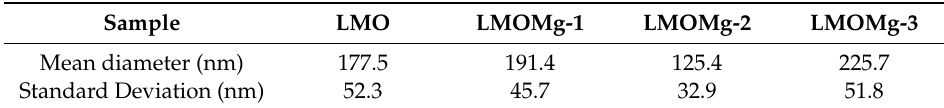
Figure 9. Differential and cumulative distribution of particle size of the nanometric powders of magnesium-doped manganese spinels: ( a ) LMO, ( b ) LMOMg-1, ( c ) LMOMg-2, and ( d ) LMOMg-3. Table 7. Results of statistical analysis of the particle size distribution for LiMg x Mn 2 − x O 4 (x = 0.00, 0.02, 0.05, 0.10) samples.